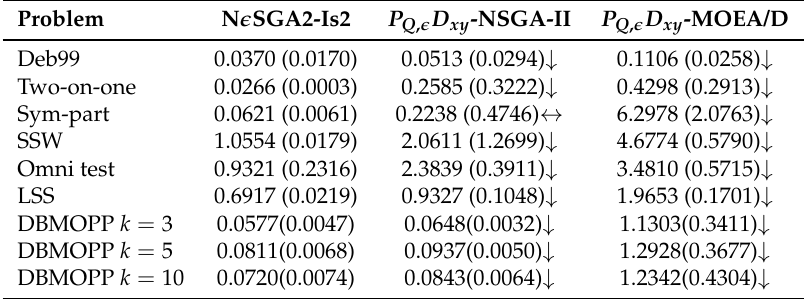
Table 6. Averaged ∆ 2 in decision space for the comparison of the state-of-the-art algorithms.